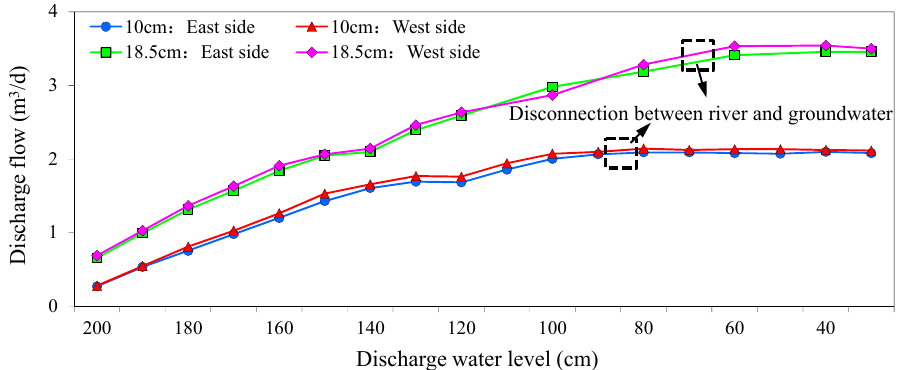
Figure 11. The relationship between discharge flow and discharge water level and river water depth under water-bearing medium sand A.